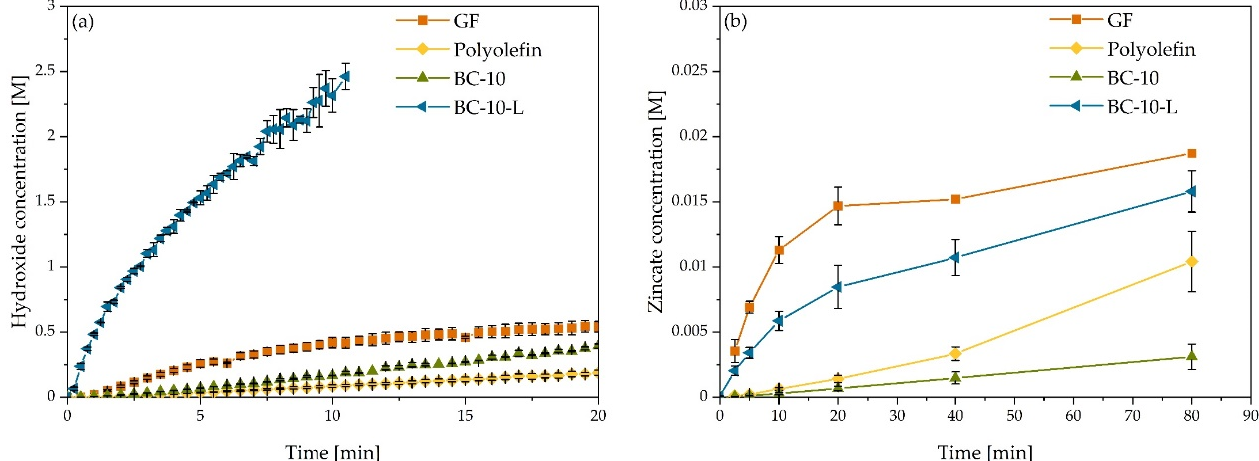
Figure 5. Concentrations of ( a ) hydroxide and ( b ) zincate ions in the draw solution during diffu- sion experiments in an H-cell. experiments in an